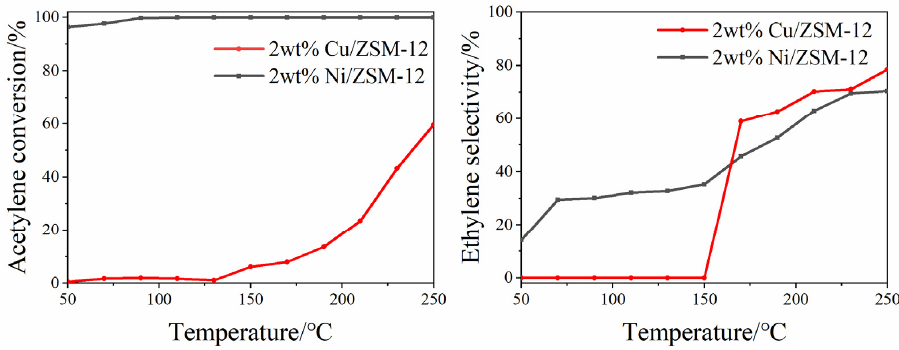
Figure 7. Catalytic performance of 2 wt% Cu/ZSM-12 and 2 wt%